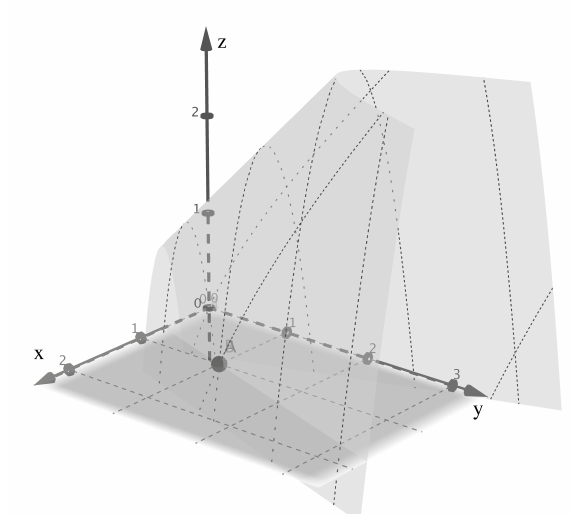
Figure 2. According to Example 10, to evaluate Z “ Y ´ X ¨ X it is necessary to optimize the function θ p λ x , λ y q “ p λ y ` 1 q ´ high